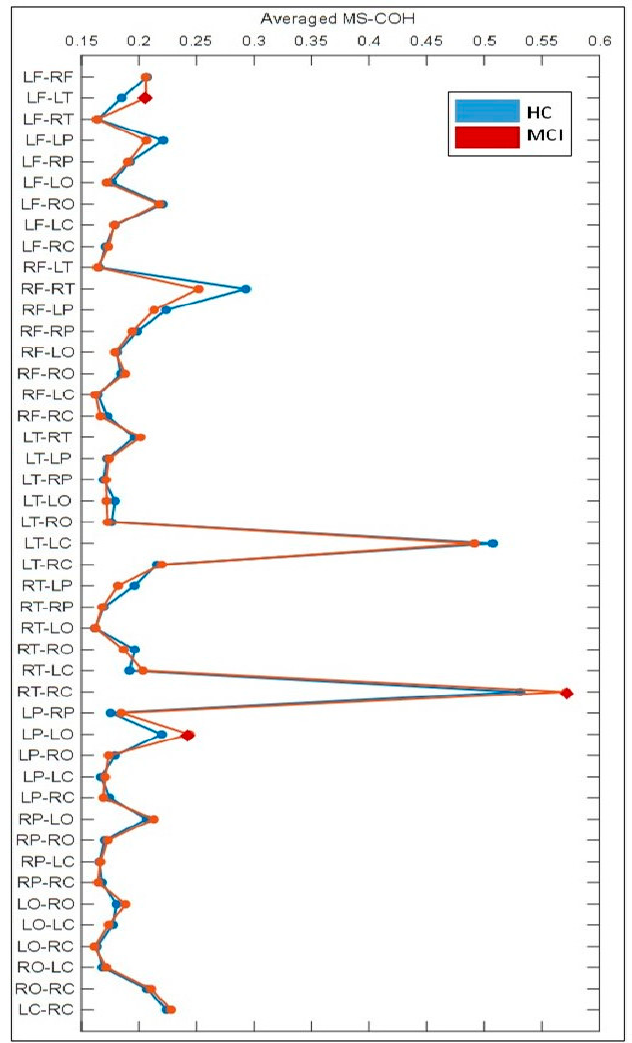
Figure 2. Comparison of average COHs for all regional pairs between HC and MCI subjects. LF-LT, RT-RC, and LP-LO pairs are highlighted using red diamonds. The ROI pairs of which are found increased COHs for MCI subjects. LT-LC region pairs are also illustrated for their relatively high FC value (on average). Note for these computations, the data of multiple participants were concatenated for analysis, the individual differences were purposely ignored.